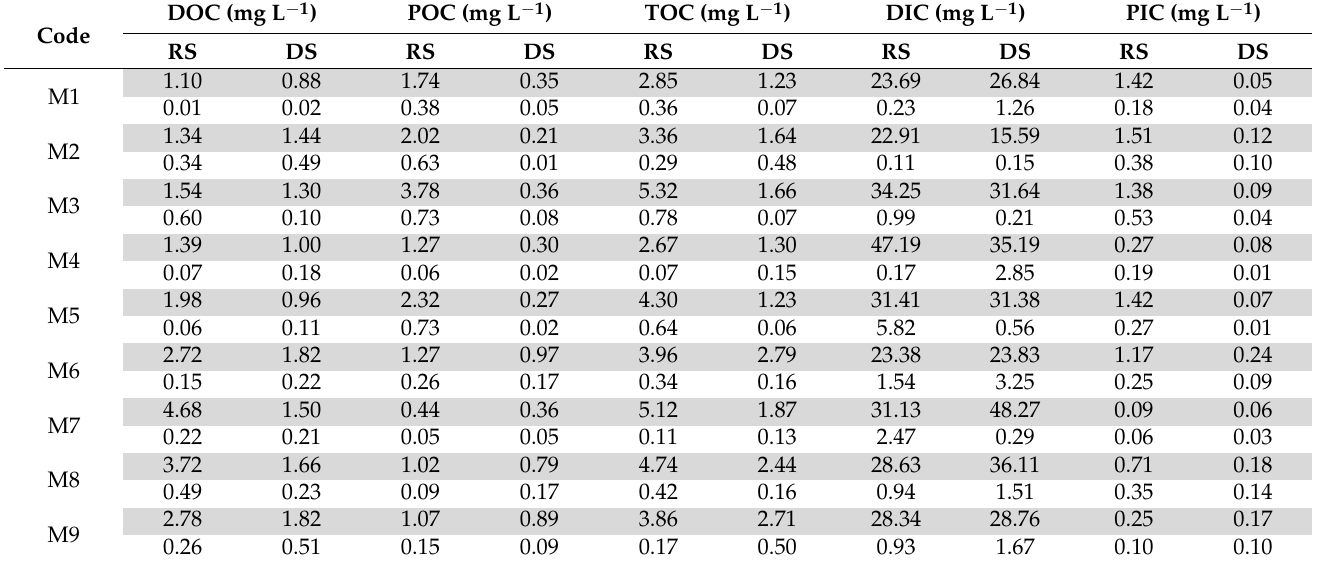
Table 1. Carbon concentrations at the Usumacinta River sampling stations during the rainy (RS) and dry seasons (DS). (For all variables, the average is in the first grey row, and the standard deviation is in the second, “-” indicates no